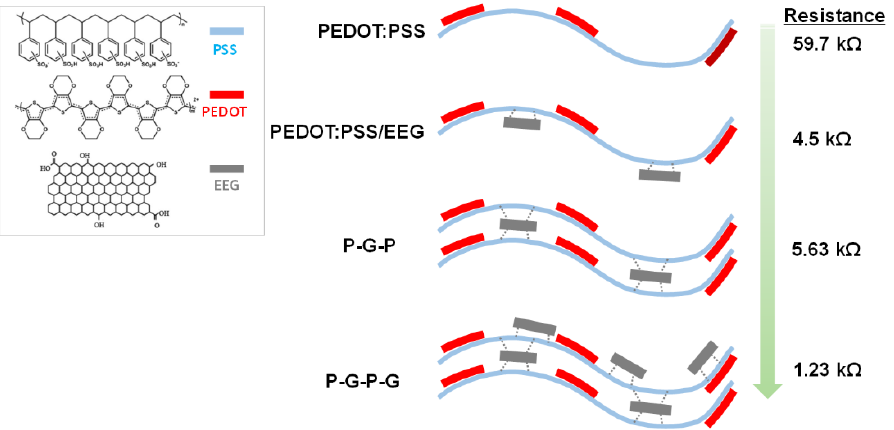
Figure 7. Schematic of the formation of PEDOT:PSS/EEG composite electrode and the multi-layer structures.